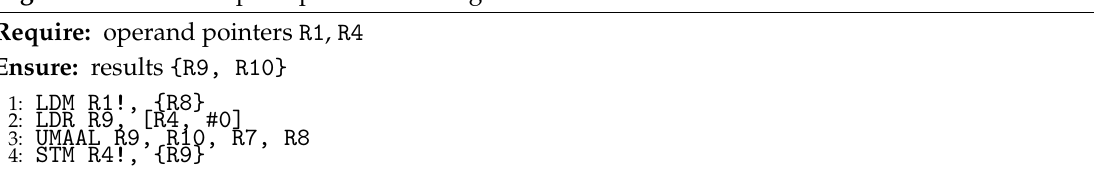
Algorithm 6 Inner loop of operand scanning.